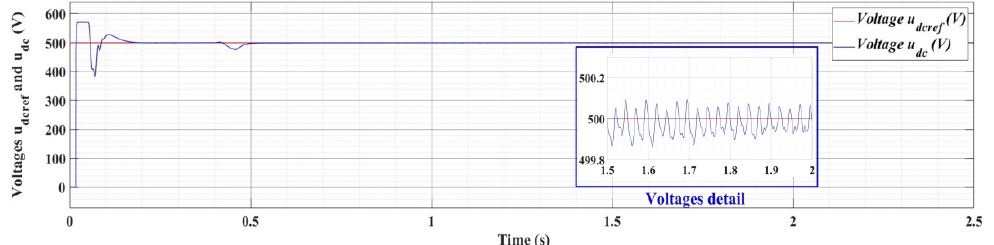
Figure 41. The time evolution of the u dc voltage for irradiance and temperature using SMC- and SYN-type controllers for a 7 kvar load (signal evolution of the type 2 PV array).